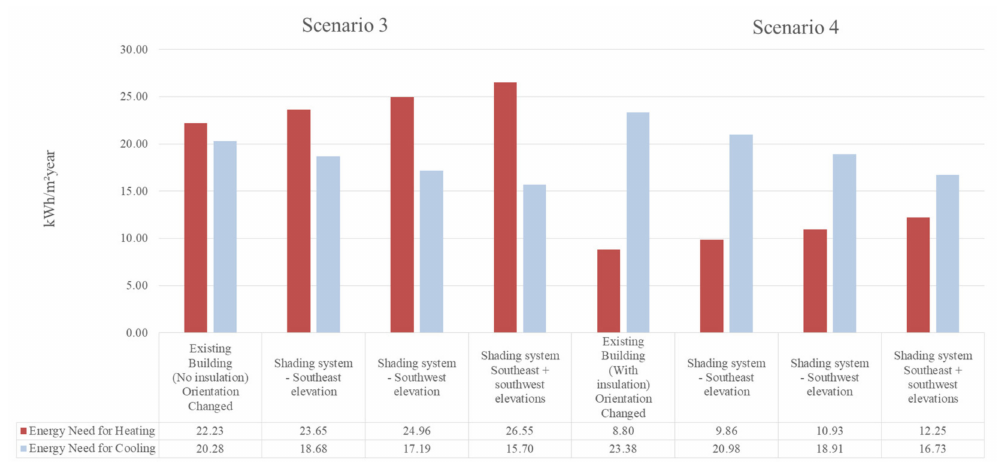
Figure 12. Calculation of the energy need (kWh/m 2 year) and Energy Certification with CYPETHERM HE Pus—scenarios 3 and